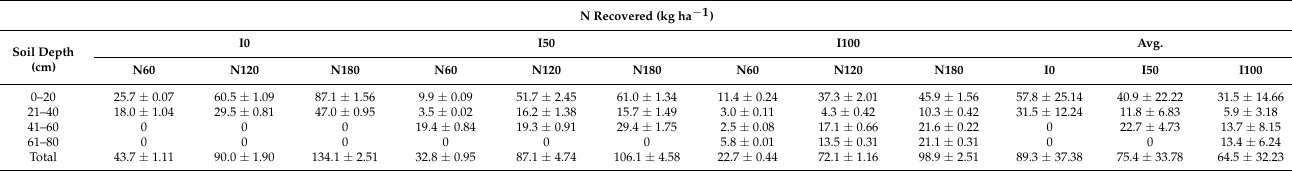
Table 3. Soil N from the fertilizer (kg ha − 1 ) at different depths in N fertilised treatments (N60, N120, N180 = 60, 120, 180 kg ha − 1 N, respectively) under no irrigation (I0), deficit (I50), and full (I100) irrigation. Values of the standard error are reported. N Recovered (kg ha − 1 )